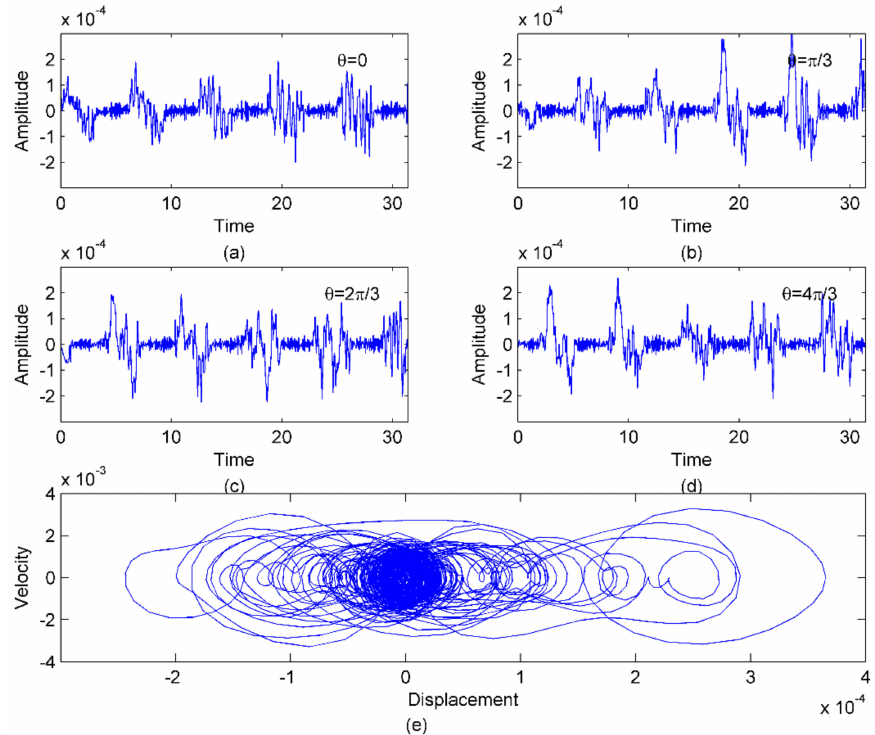
Figure 9. Forced response of the planet ring in the u direction at different positions, where ( a ) θ = 0, ( b ) θ = π /3, ( c ) θ = 2 π /3, and ( d ) θ = 4 π /3; ( e ) phase diagram of the position θ = π /3.